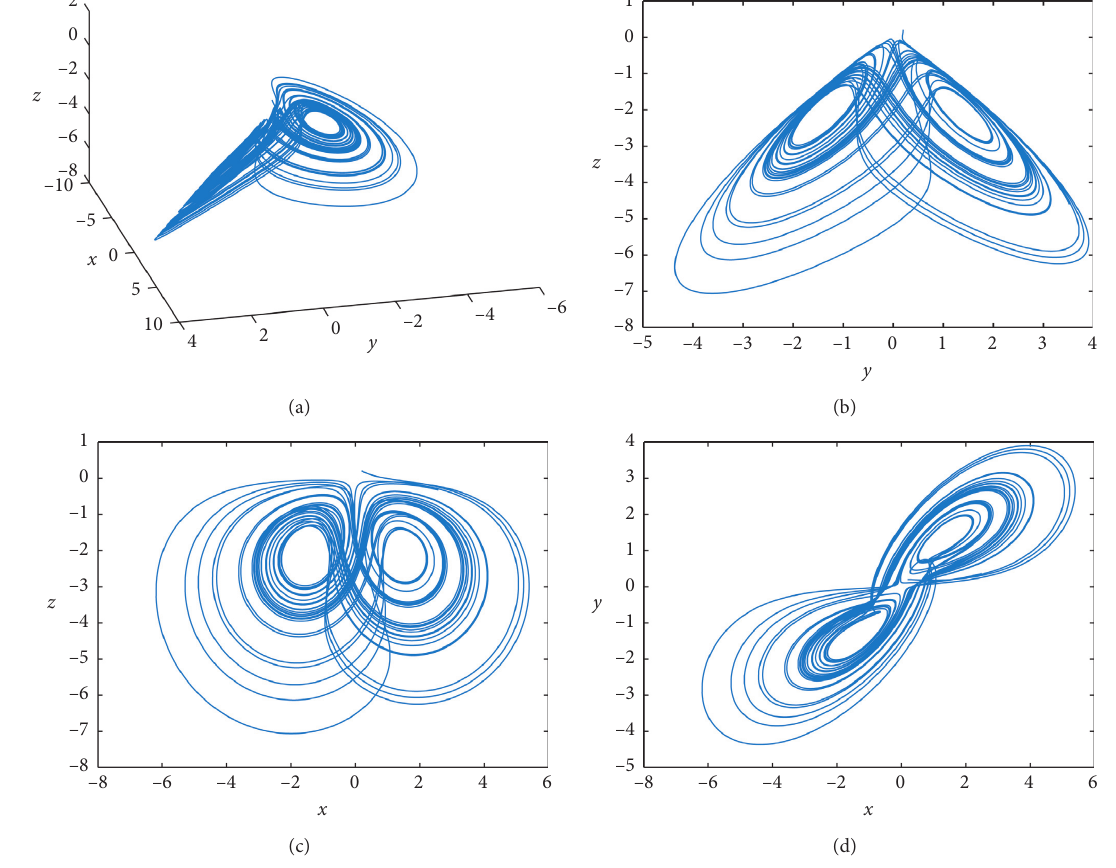
Figure 16: Phase portraits with system